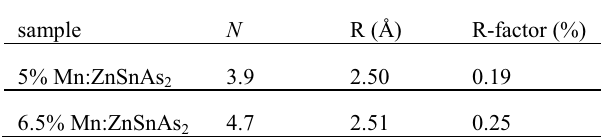
Table 1. Summary of curve fitting